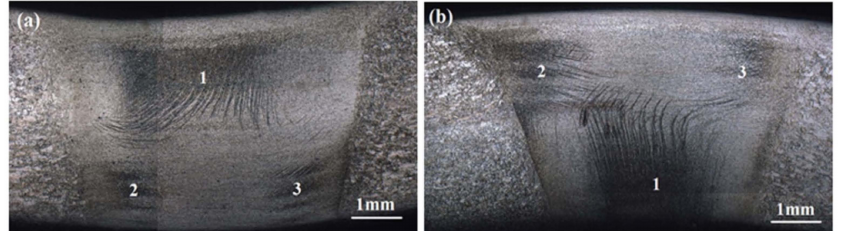
Figure 6. Microstructure characteristics of the FSWed AZ31 Mg joint after bending with a strain of 5% ( a ) surface test sample and ( b ) base test sample.